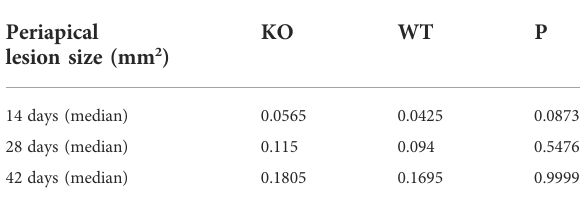
TABLE 2 Apical lesion of each mouse.